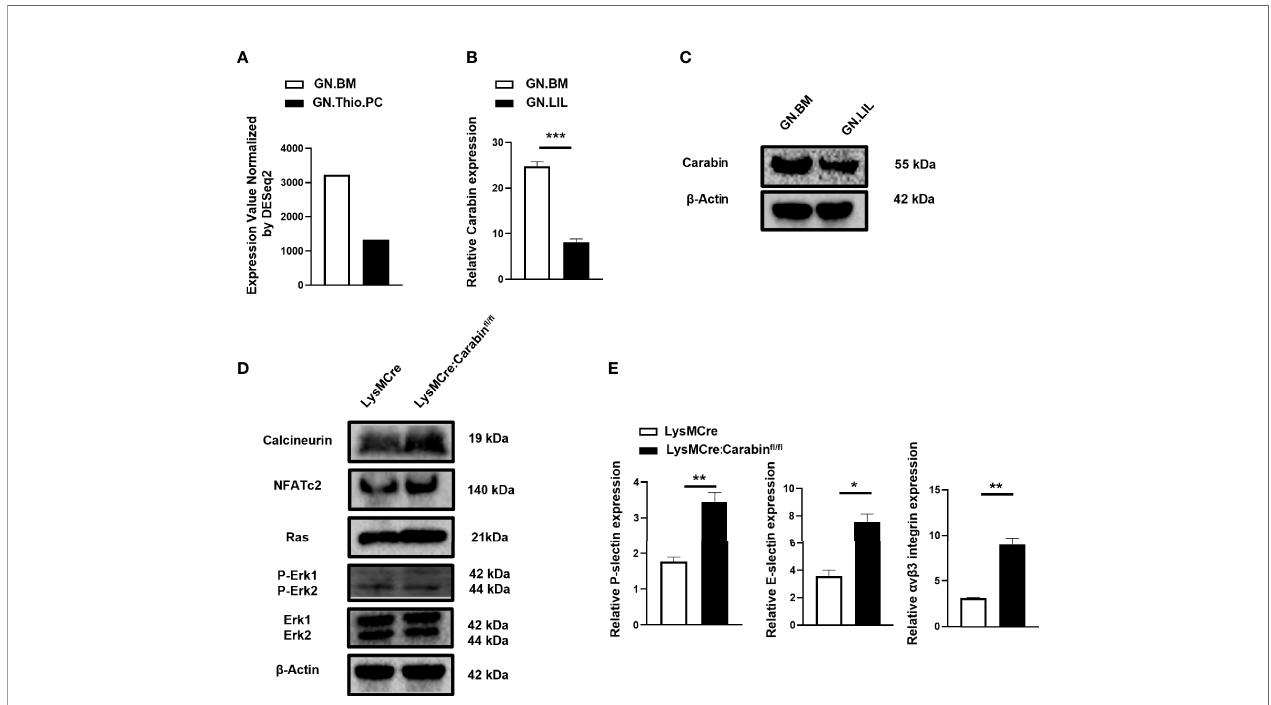
FIGURE 3 | Carabin suppresses the expression levels of P-selectin, E-selectin, and a v b 3 integrin in neutrophils through inhibiting Ras-ERK and Calcineurin-NAFT pathways. (A) The mRNA level of Carabin was analyzed from ImmGen datasets in thio-induced peripheral neutrophils (GN.Thio.PC) and bone marrow neutrophils (GM.BM). (B) The mRNA level of Carabin was measured in CD11b + Ly6G + neutrophils isolated from liver-in fi ltrating leukocytes after HIRI in WT mice and in bone marrow cells in sham-control mice. (C) Western blotting was used to test the protein expression of Carabin in CD11b + Ly6G + neutrophils isolated from liver-in fi ltrating leukocytes after HIRI in WT mice and in bone marrow cells in sham control mice. (D) The protein levels of calcineurin, NFAT, Ras, ERK, and P-ERK were measured by Western blotting in liver-in fi ltrating CD11b + Ly6G + neutrophils isolated from LysMCre : Carabin fl / fl mice and LysMCre mice after HIRI. (E) The expression levels of P-selectin, E-selectin, and a v b 3 integrin were measured by qRT-PCR. Data are presented as the mean ± SEM (n = 5 mice/group). Data are presented as mean ± SEM (n = 5 mice/group). *P < 0.05; **P < 0.01; ***P <